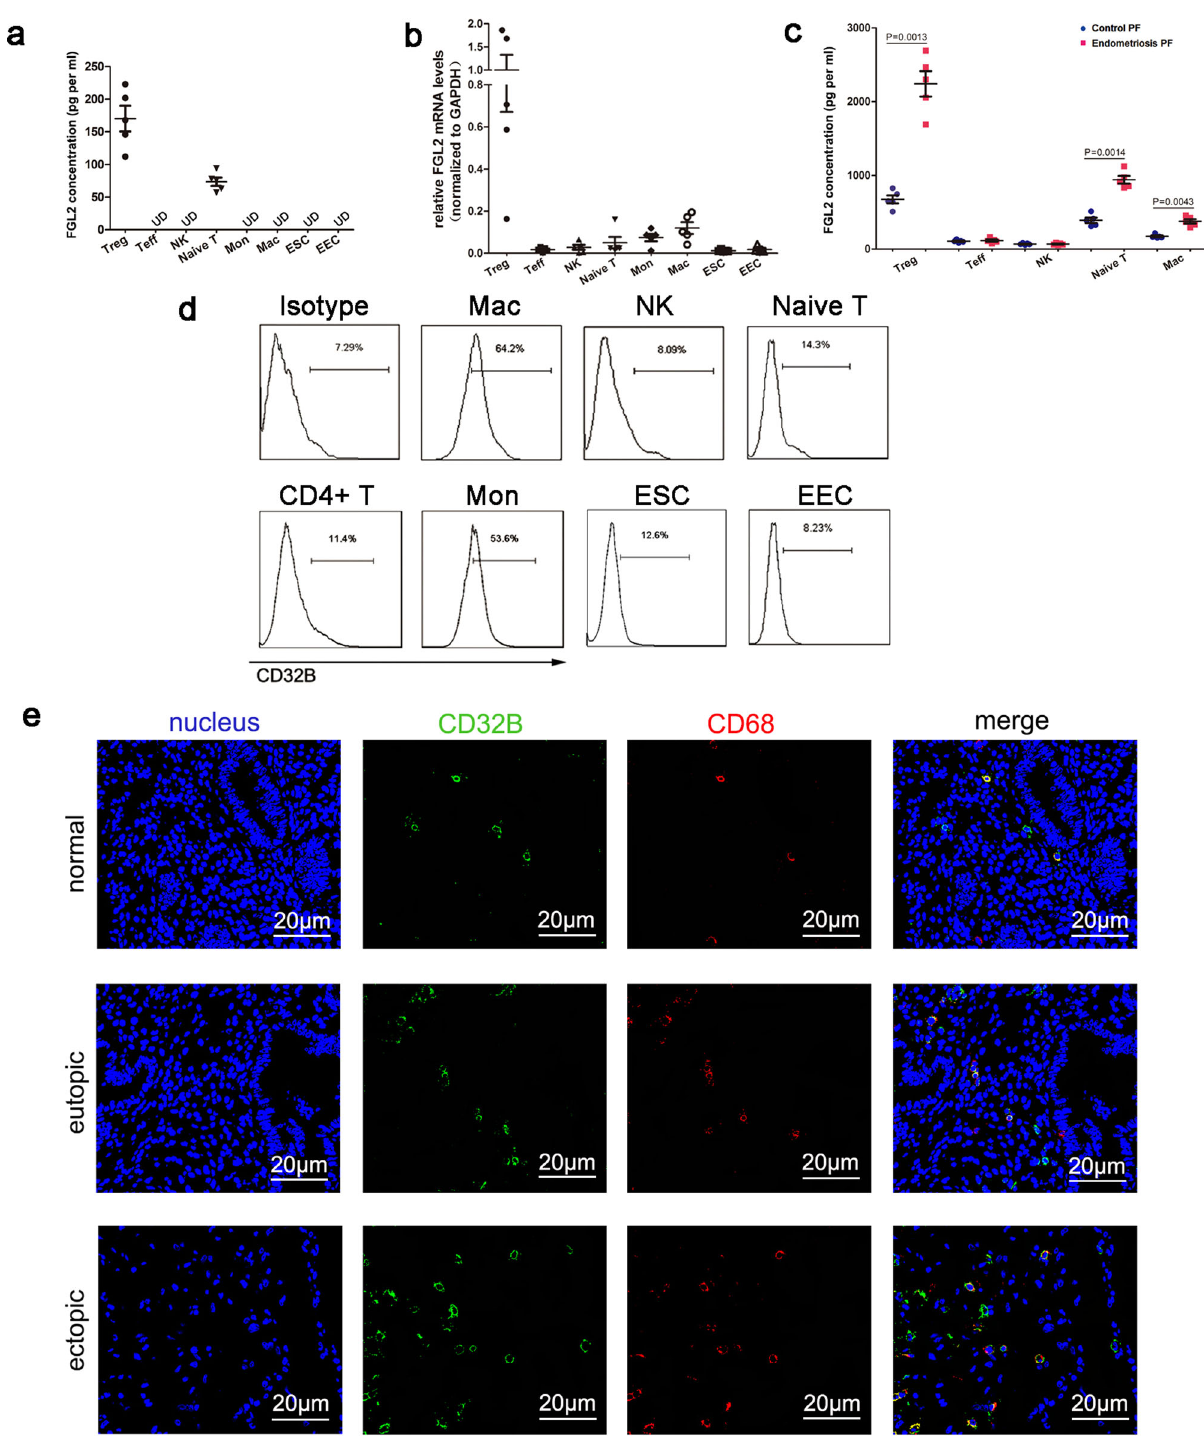
Fig. 2 The expression of FGL2 and CD32B on isolated cells and in tissues. a ELISA for FGL2 concentrations in cell culture supernatant. b FGL2 mRNA expression levels in different kinds of cells. ( a , b ) The individual immune cell populations were isolated from PBMC. EECs and ESCs from endometrium were primary cultured. c ELISA for FGL2 concentrations in cell culture supernatant. The individual immune cell populations were isolated from the peritoneal fl uid of women with or without endometriosis (PF: peritoneal fl uid). d CD32B expression on cell surfaces was measured by FCM. e Confocal microscopic analysis of nucleus (blue), CD32B (green), CD68 (red), expression in normal endometrium, eutopic endometrium, and ectopic lesions. Data represent the mean FGL2 levels of individual immune cell populations from peritoneal endometriosis were mainly produced by Tregs. CD32B was mainly fl uid of women with or without endometriosis and we found that expressed on monocyte and macrophages, and showed lower Tregs in peritoneal fl uid of endometriosis patients secreted sig- levels of expression in other cells (Fig. 2d). Confocal microscopy ni fi cantly higher levels of FGL2 than that of control (Fig. 2c). showed that the number of CD32B positive cells increased in both Therefore, high levels of sFGL2 in peritoneal fl uid of patients with eutopic endometrium and ectopic tissues (ovarian endometriosis)